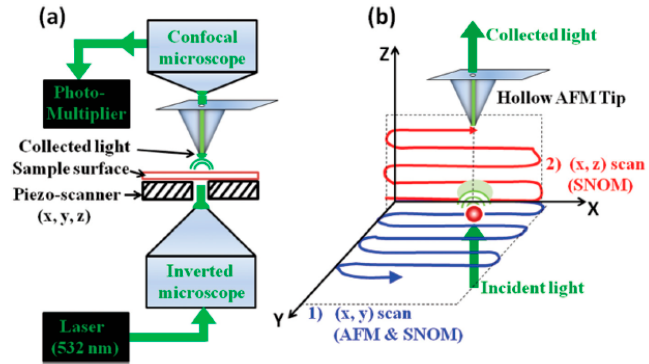
Figure 5. Schematic of collection mode operation 3D SNOM system. ( a ) The piezo-scanner is capable of moving the tip in x , y and z directions to position the tip in any location in 3D space; ( b ) In the 3D SNOM configuration, SNOM and topography images can be simultaneously obtained from AFM/SNOM scans of the x - y plane along the sample surface. Scanning along x-z planes at a constant y can be used to obtain a cross-section of light scattered by nanostructures at different heights from the sample surface. Reproduced with permission from [48], Copyright Nanoscale, 2015.